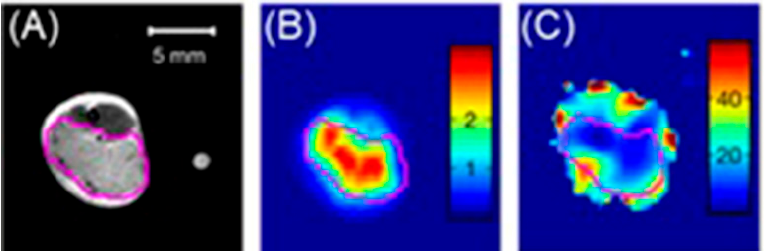
Figure 18. Tumor slice (Z = 2 mm) of a mouse (23.0 g) bearing a leg-born squamous cell carcinoma. ( A ) T 2 -weighted MR image defining the boundary of the tumor and marked by the pink line. ( B ) PET image of the same slice exhibits large uptake of 9 in the tumor, indicated by red color, and ( C ) pO 2 image of the tumor slice acquired by EPRI. The hypoxic region is indicated by dark blue color. Adapted with permission of Royal Society of Chemistry, from Development of a PET/EPRI combined imaging system for assessing tumor hypoxia, Kim, H.; Epel, B.; Sundramoorthy, S.; Tsai, H. M.; Barth, E.; Gertsenshteyn, I.; Halpern, H.; Hua, Y.; Xie, Q.; Chen, C. T.; Kao, C. M. 16 , 03, 2021 ; permission conveyed through Copyright Clearance Center, Inc. [288].